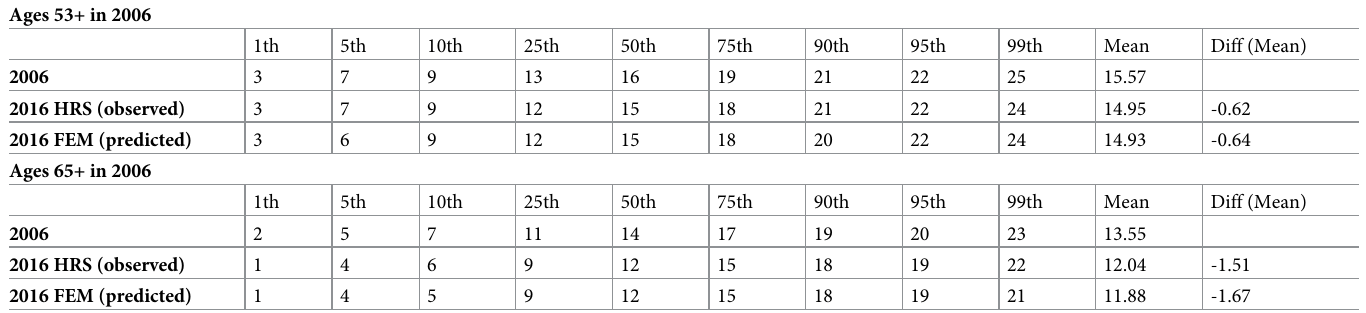
Table 3. Distribution comparison between HRS respondents and FEM simulation, 2006–2016.